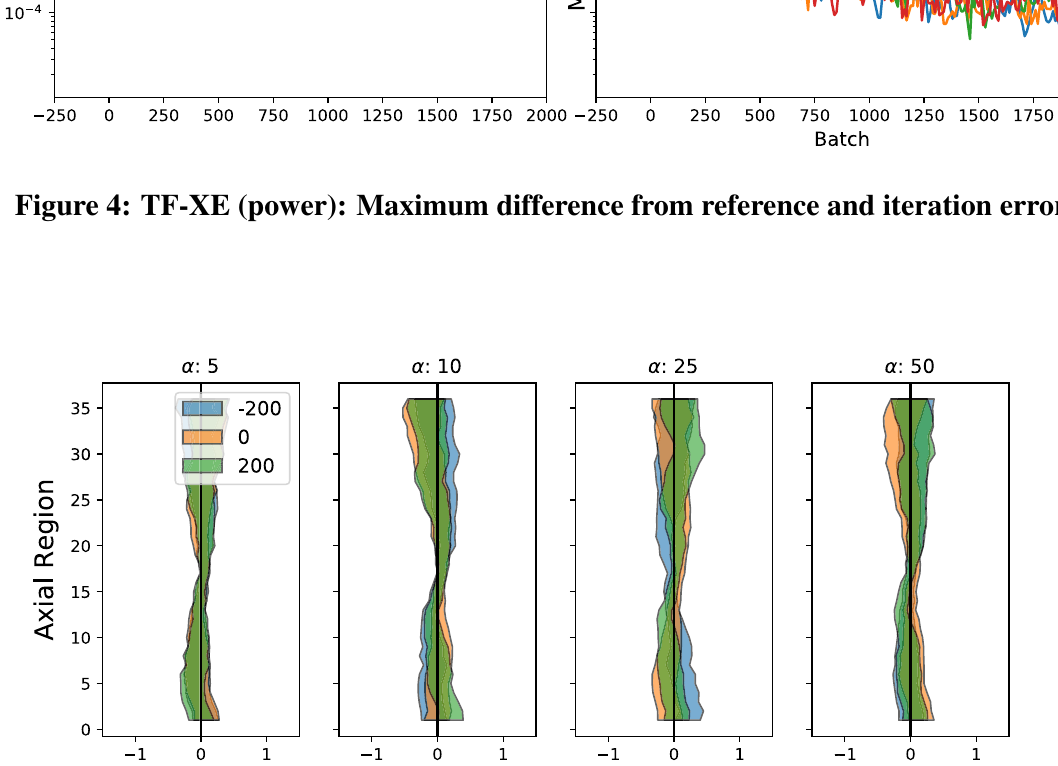
less frequently (thermal α = 25 , 50 ), as frequently as (thermal α = 10 ), and more frequently (thermal α = 5 ) than thermal feedback. The iterations were not staggered at all such that for thermal α = 10 both xenon and thermal were being updated after the same batches. Figure 4 again shows the maximum relative difference from the reference and the maximum iteration-to- iteration error. Results are very similar to the TF case – the inline iteration approach appears to be insensitive to the particular running strategy used and the expected level of convergence to the reference solution is